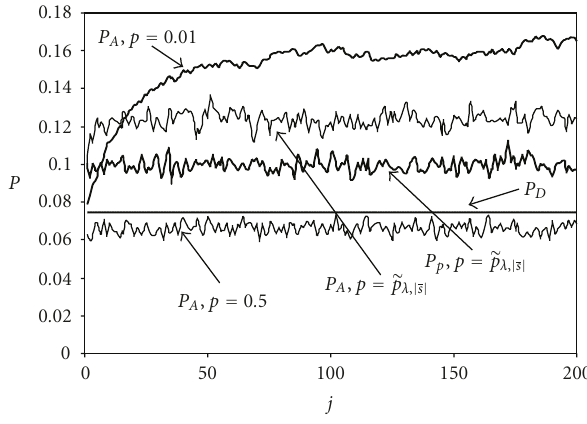
Figure 2: System throughput ( P ) simulation results for heavy tra ffi c conditions, λ = 1, for each frame j